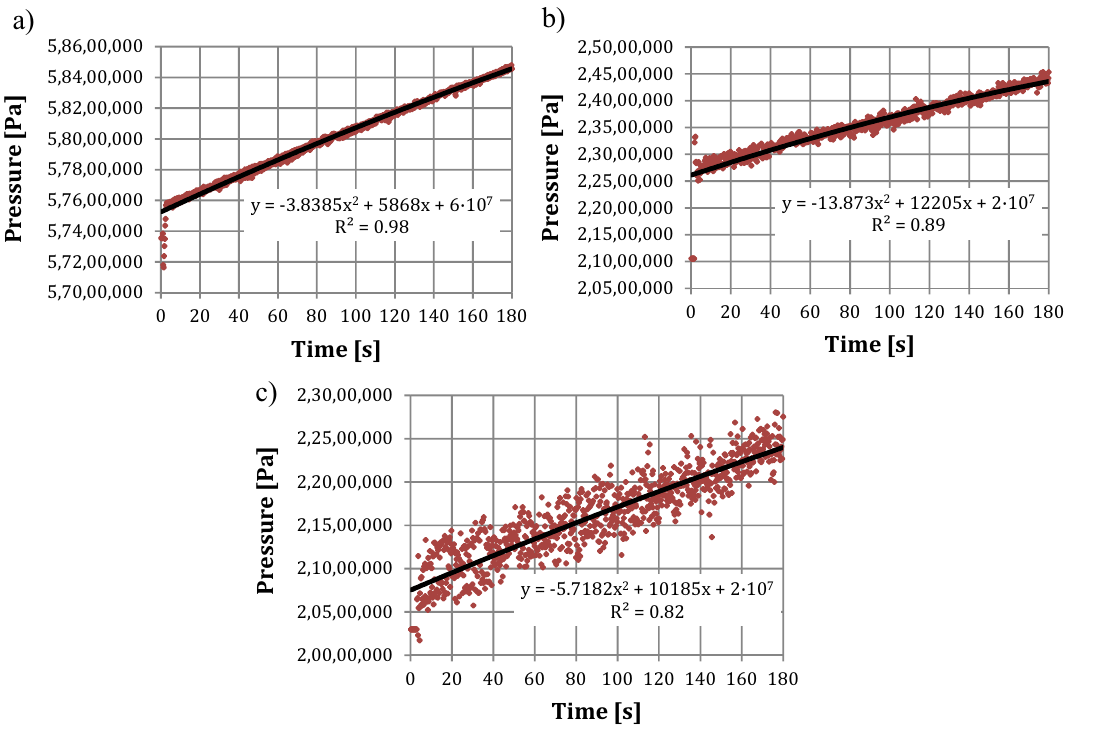
Figure 14. The pressure changes of the water stream for a given distance from the outlet of the nozzle depending on the time: ( a ) at the outlet of the nozzle; ( b ) for a distance of 0.05 m from the inlet of the nozzle; ( c ) for a distance of 0.10 m from the inlet of the